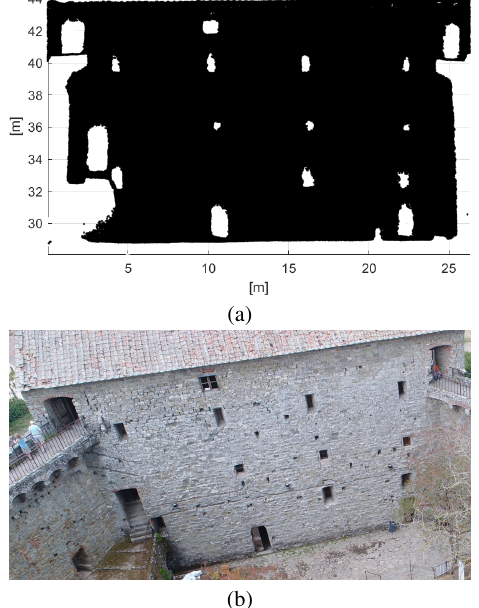
Figure 7. (a) Areas (in white) detected as not part of the inner wall of the fortress. (b) A photo of the wall analyzed in (a).